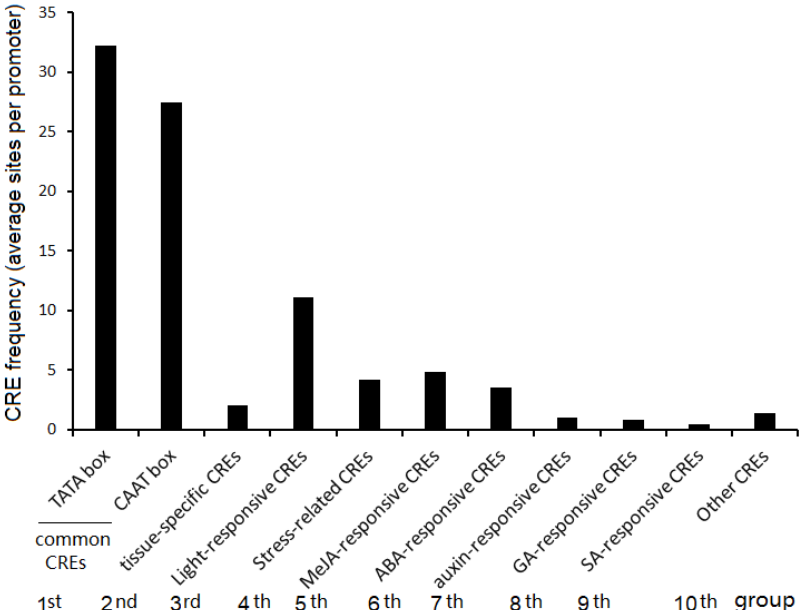
Figure 7. Classification of CREs identified in the promoters of MAPS genes; 2-kb promoter regions upstream of the start codon (ATG) of 618 MAPS genes were scanned to obtain the CRE sites by “Search for CARE” from PlantCARE web. The search retrieved 95,631 CRE sites, which belong to 123 CREs. Those CREs were classified manually into 10 groups according to their functional annotation.